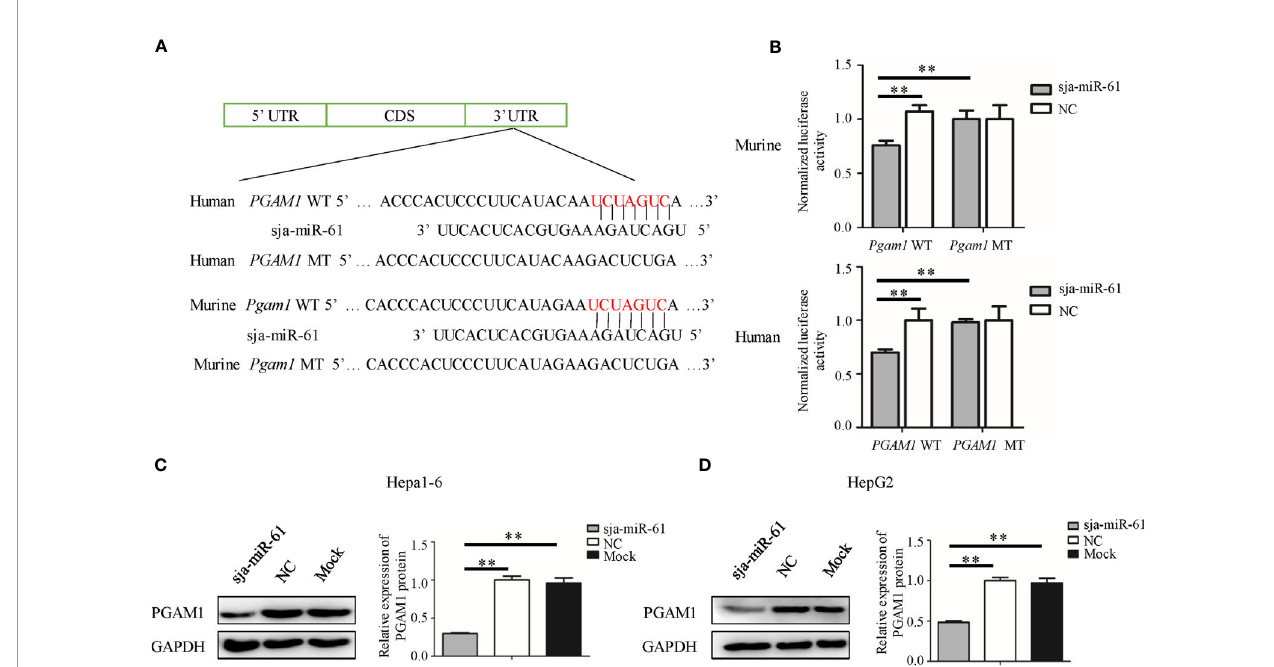
FIGURE 3 | PGAM1 as target of sja-miR-61. (A) A schematic diagram representing the wild-type or mutant 3 ’ untranslated region (UTR) targeting sites of murine Pgam1 and human PGAM1 genes. (B) A dual-luciferase reporter assay was used to measure the activity of the reporter gene, and the fi re fl y luciferase activity was normalized to renilla luciferase activity. (C, D) The protein levels of murine PGAM1 (C) and human PGAM1 (D) were measured using Western blotting in the hepatoma cells transfected with sja-miR-61 mimics or NC mimics, respectively. Data are presented as the mean ± SD, n = 3, ** p <